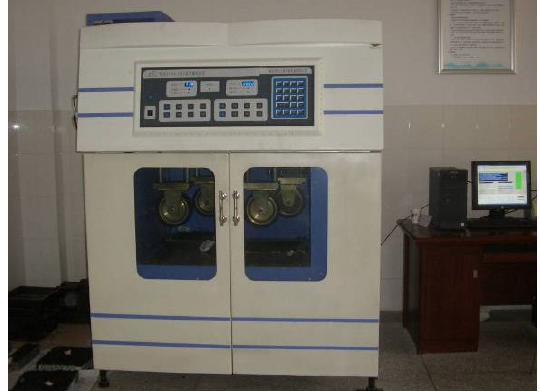
Figure 5. Wheel-tracking test device.